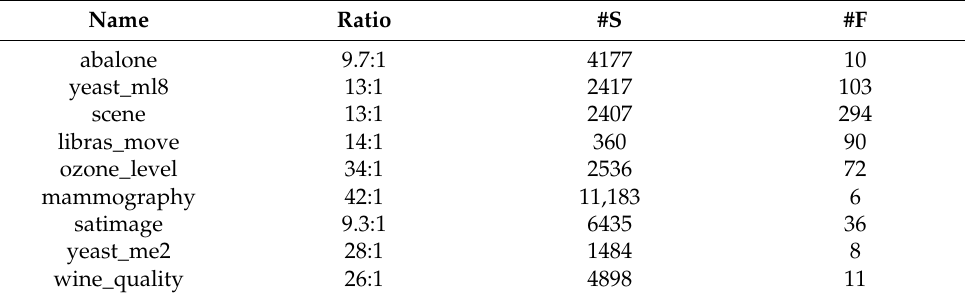
Table 4. Details of the experimental datasets.